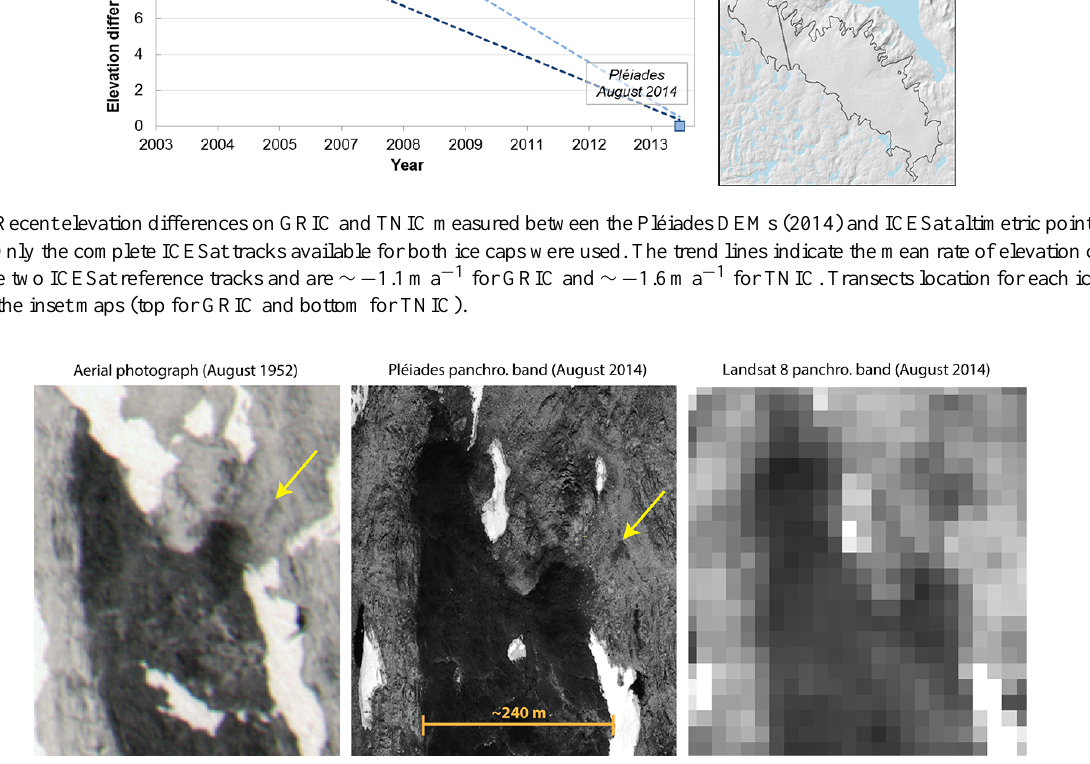
Figure 8. Representation of the same geomorphological feature on ice-free terrain surrounding GRIC using three different technologies, namely an aerial photography (August 1952), a Pléiades panchromatic band (3 August 2014) and a Landsat 8 panchromatic band (15 Au- gust 2014). Note the very fine resolution of the Pléiades panchromatic band (70cm), in comparison to the Landsat 8 panchromatic band (15m), allowing to retrieve bedrocks and ice-free features on archives aerial photos and thus to collect GCPs (e.g. at the bedrock localised by the yellow